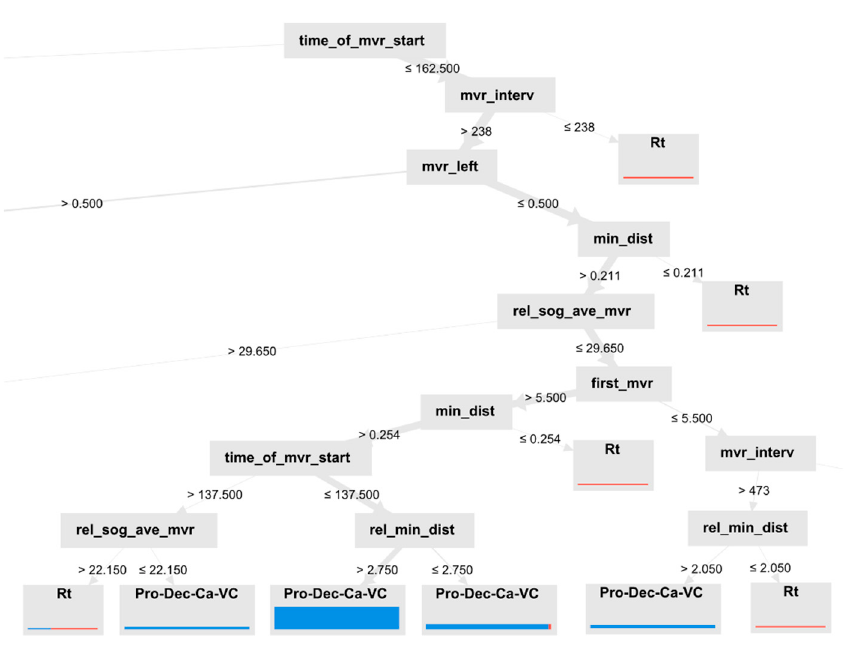
Figure 8. Decision tree #3—fragment.